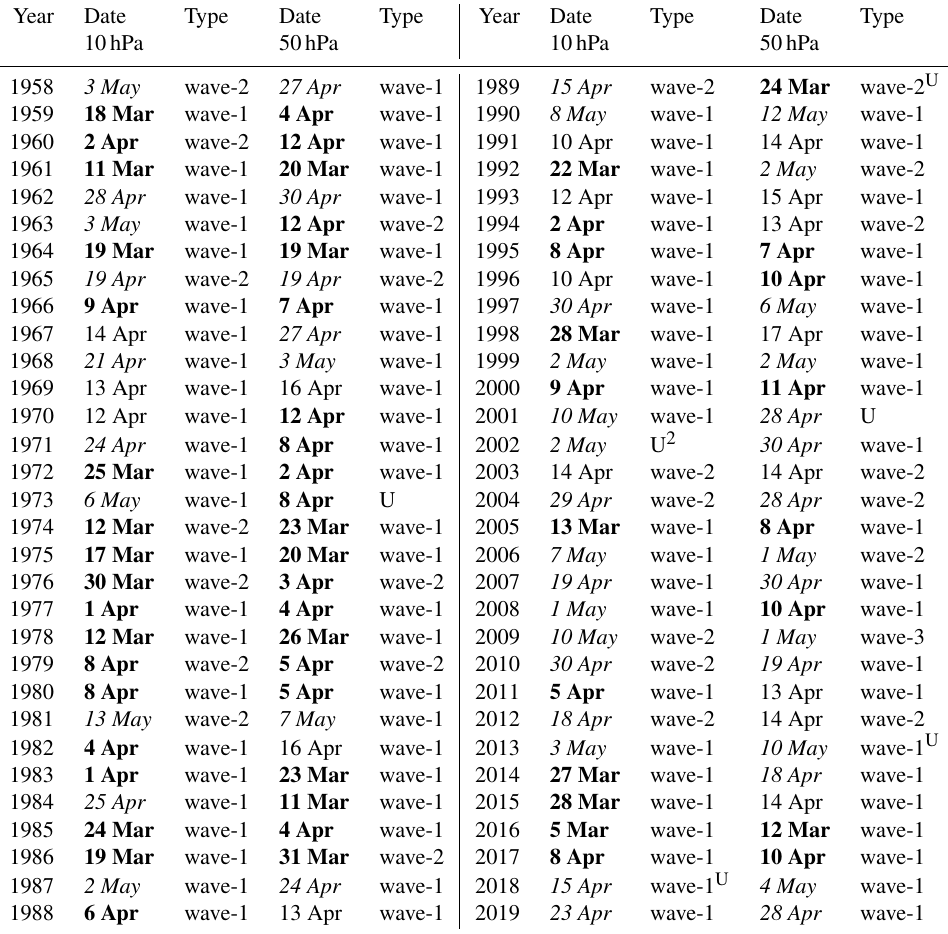
Table 1. Dates and classifications for FSW events in the Northern Hemisphere according to JRA-55 reanalysis. Early (late) events are indicated in bold (cursive), referring to a date before (after) the median date of 12 April at 10hPa and 15 April at 50hPa. Dates that fall within ± 2d of the median date are not classified as early or late. U = unclassified (methods did not agree according to the criterion outlined in Sect. 2). Superscripts indicate the ERA-interim classification if it was not in agreement with JRA-55 during the 1979–2019